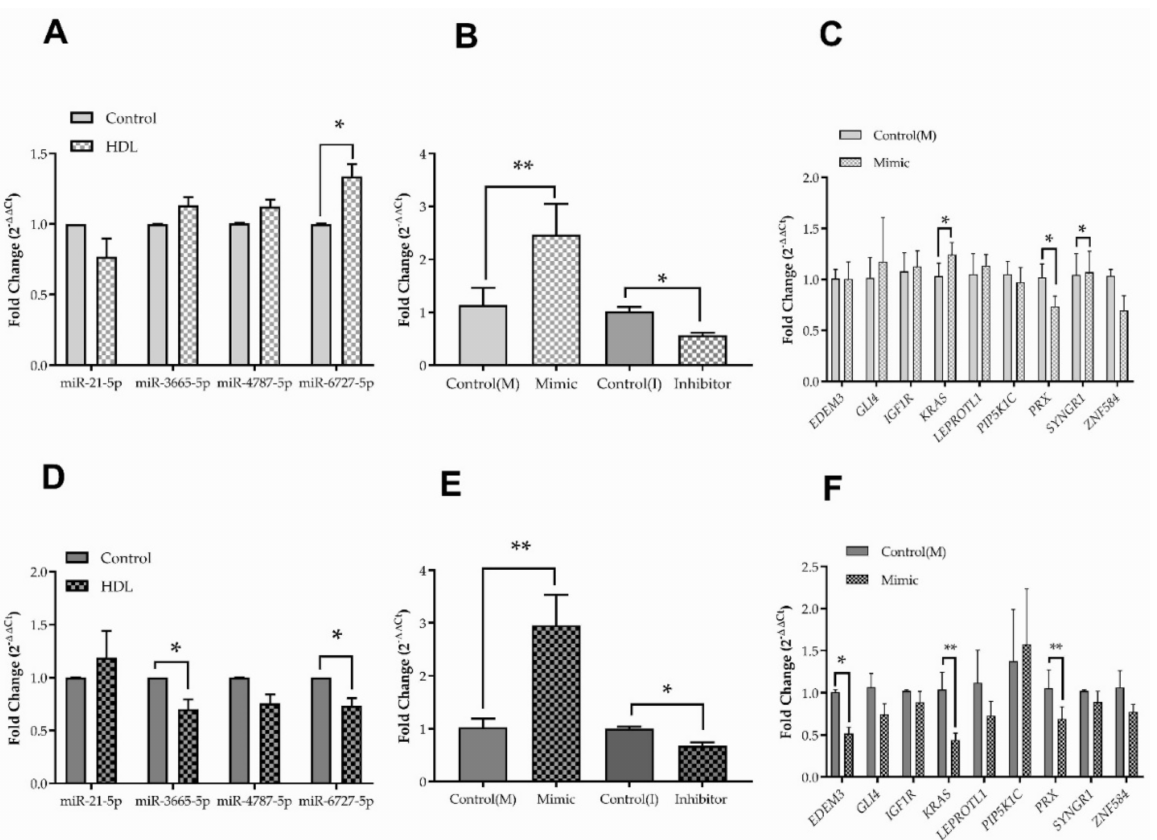
Figure 5. The effect of treatment with HDL (20 µ g mL − 1 ; 24 h) on fold changes in expression of the miR sequences indicated, in HDFn and HDFa, are shown in ( A , D ), respectively, compared with an invariant housekeeping sequence SNORD 72. Values are the mean ± SEM of n = 3 ( A ) and n = 4 ( C ) independent experiments; statistical analysis was performed using the ∆ Ct values and a paired Student’s t -test. Changes in expression due to delivery (24 h) of 10 nM hsa-miR-6727-5p mimic (M) and 50 nM hsa-miR-6727-5p inhibitor (I) to HDFn and HDFa, compared with the relevant scrambled control sequences, and expressed relative to housekeeping sequence SNORD72 are shown in ( B , D ), respectively. Values are the mean ± SEM of n = 4 ( B ) and n = 3 ( E ) independent experiments; statistical analysis was performed using ∆ Ct values and a paired Student’s t -test. * p < 0.05; ** p < 0.01. The impact of hsa-miR-6727-5p mimic (10 nM, 24 h), compared with the scrambled control sequence, on the repression of gene expression expressed relative to GAPDH, in HDFn and HDFa are shown in ( C , F ), respectively. Values are the mean ± SEM of three independent experiments; statistical analysis was performed using ∆ Ct values and a paired Student’s t -test. * p <